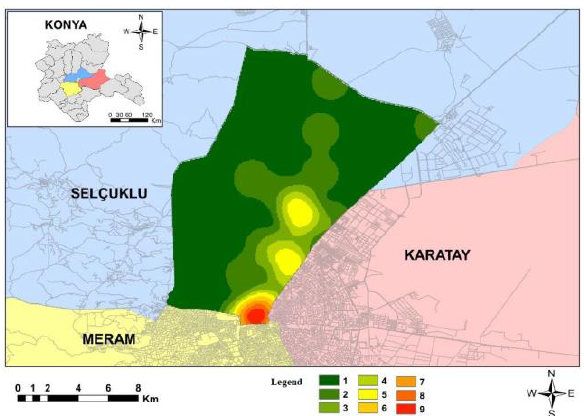
Figure 7. Public facilities density analysis